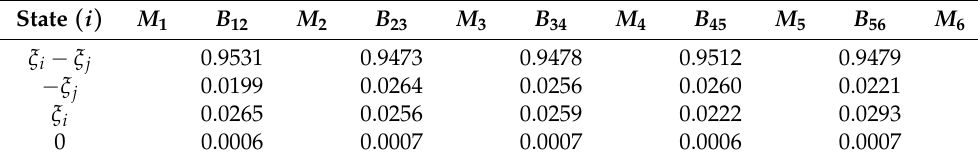
Table 2. Probability distribution for the process φ ( t ) in each buffer. State ( i